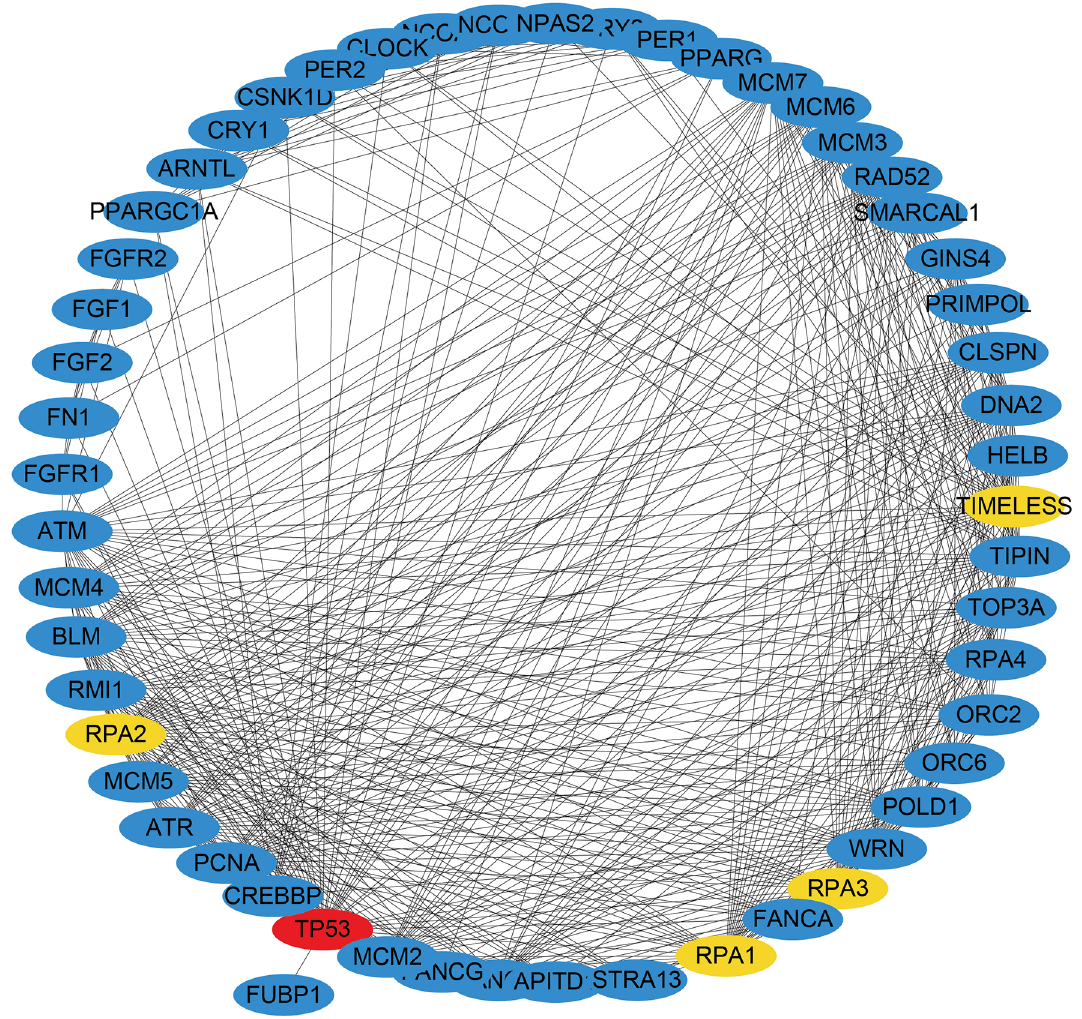
Figure 5. Analysis of hub genes from the PPI networks of common DEGs according to the degree value. The highlighted nodes represent the identified hub genes. Red color node represents the gene with the largest degree value in the PPI networks.